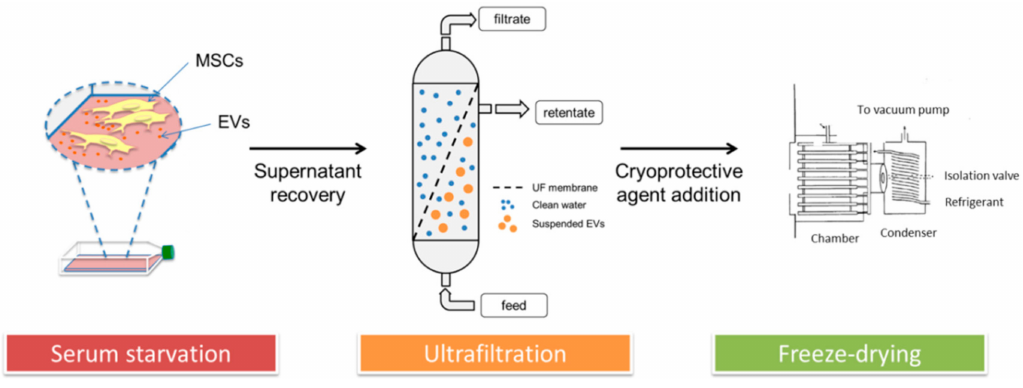
Figure 1. Lyo-secretome production